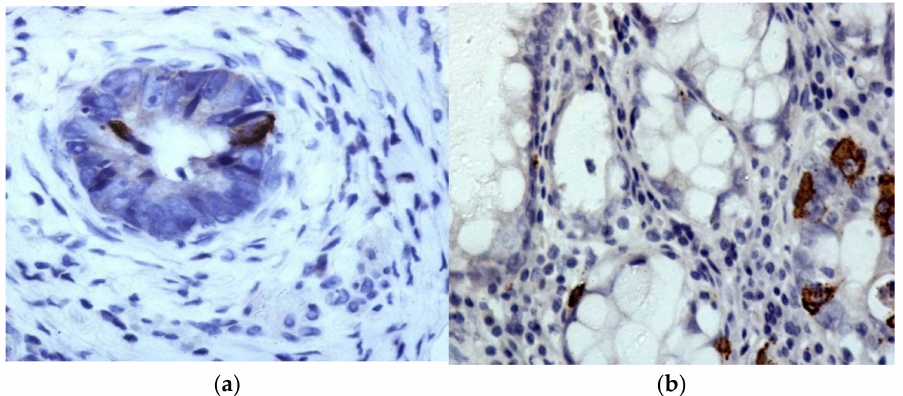
Figure 4. Immunohistochemical reaction with ChrgA antibodies in adenocarcinoma cells and in the resection region. ( a ): ChrgA expression in RC; ( b ): moderate and weakly expressed specific coloring is determined in the resection edge. Chromogen–diaminobenzidine. Control staining with hematoxylin staining. Magnification: ×